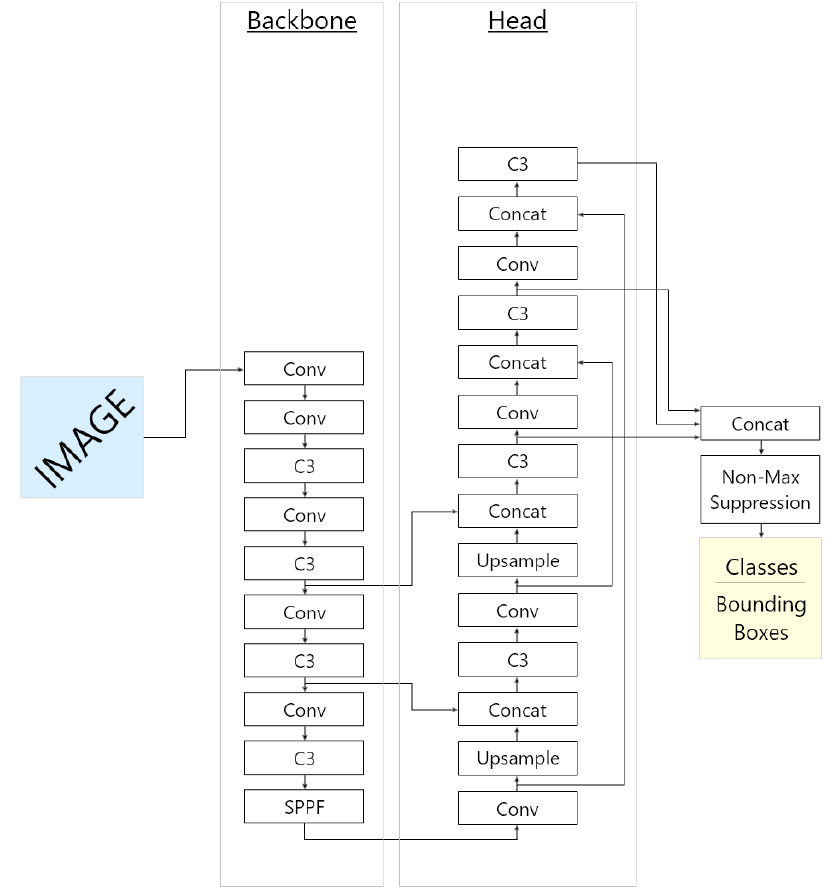
Figure 4. YOLOv5